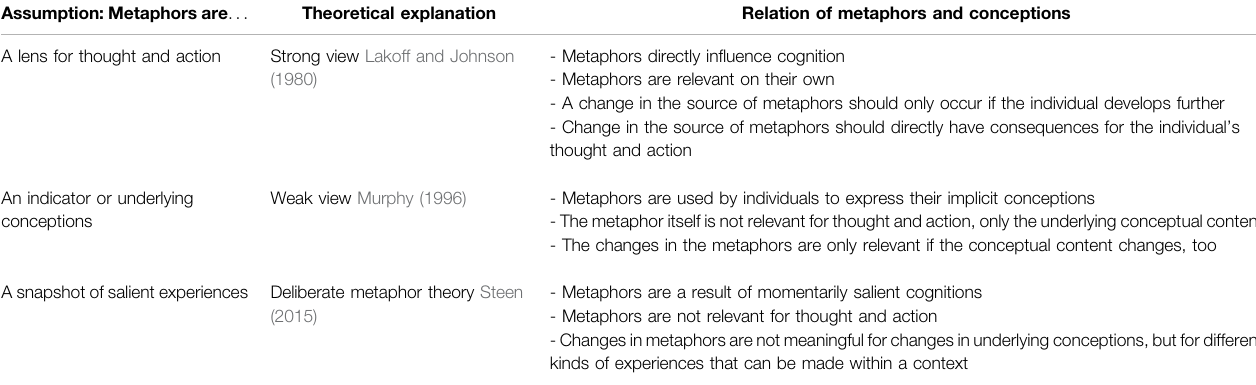
TABLE 1 | The assumptions of the relationship of metaphors to other constructs. Assumption: Metaphors are